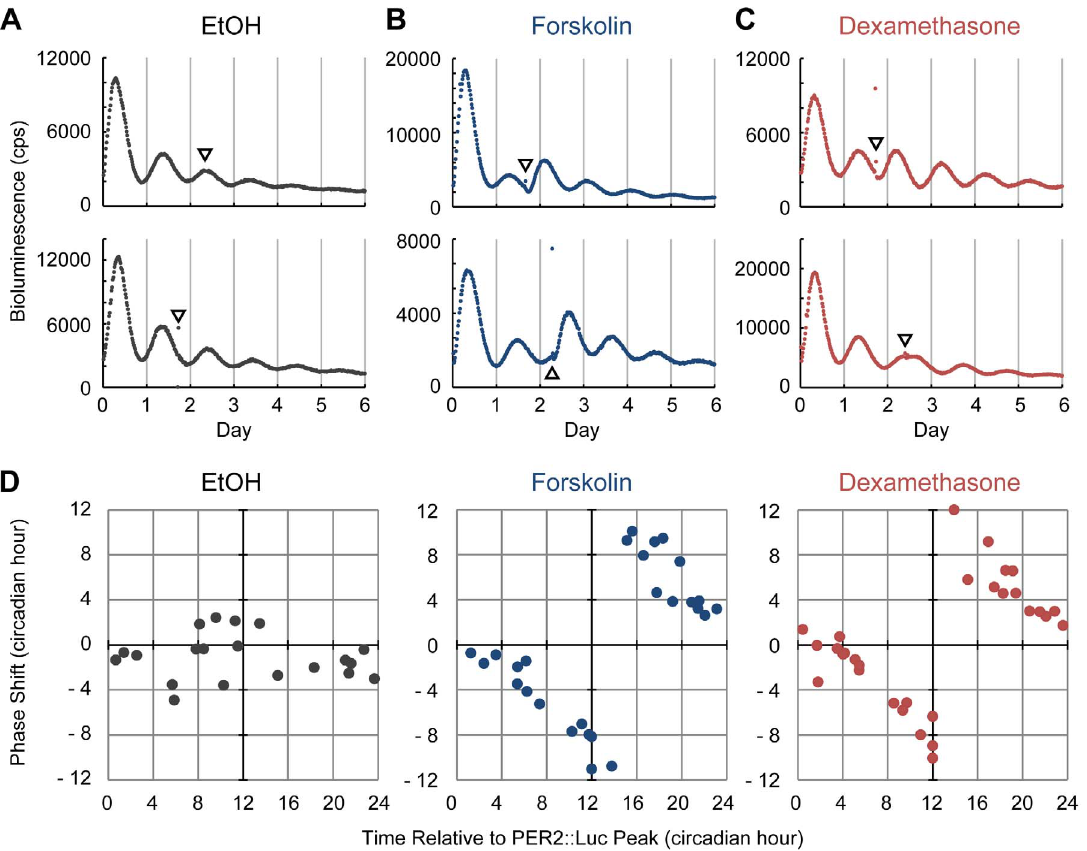
Figure 4. Phase resetting of bone circadian clocks by chemicals. ( A–C ) Effects of forskolin and dexamethasone (DEX) on circadian clocks. Representative data showing the phase advancement ( upper panels ) or phase delay of the bone circadian clock ( lower panels ). The arrowhead indicates chemical administration. From left to right, the vehicle (ethanol; EtOH) ( A ), DEX ( B ), or forskolin ( C ). ( D ) Phase response curves for the vehicle (left), forskolin (middle) or DEX (right). Results of 20 (vehicle), 27 (forskolin), and 30 (Dex) experiments were plotted, respectively. The horizontal axis represents time relative to PER2::Luc peak time (CT12) and the vertical axis represents phase shift. Data are represented in circadian hours (1 circadian hour = period length (hour) /24).